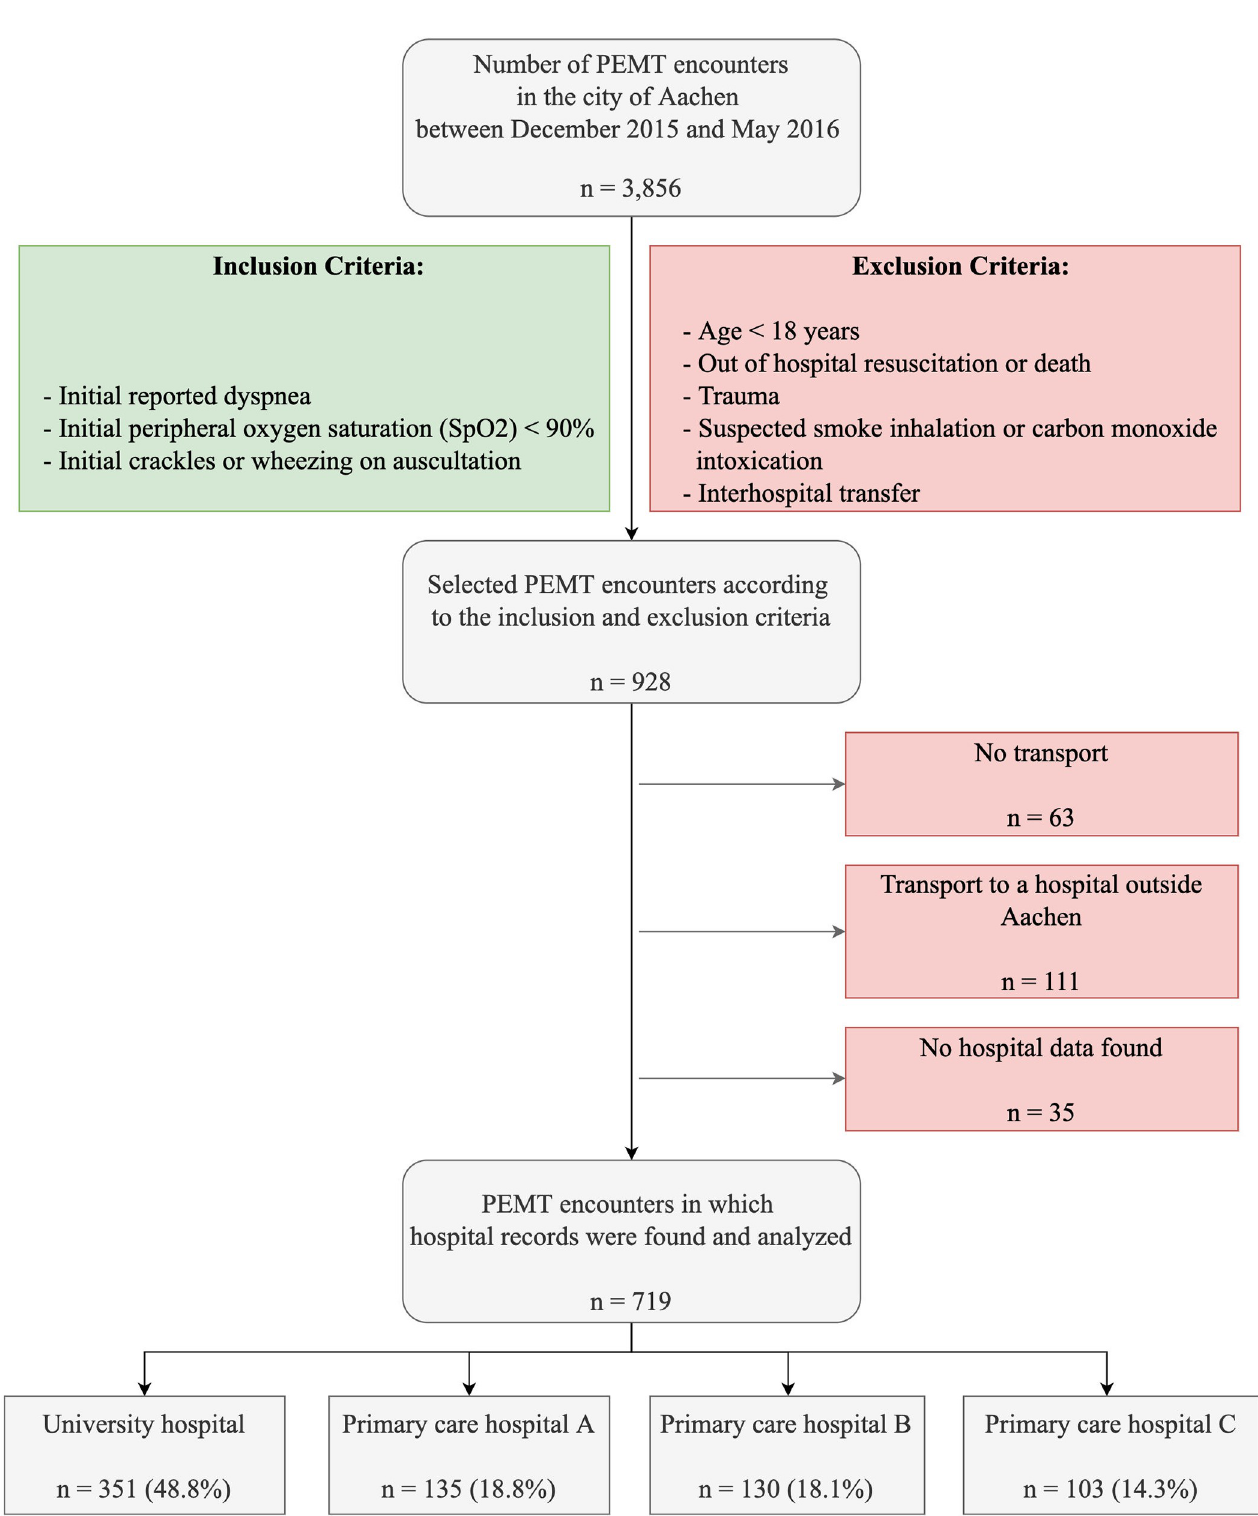
Fig 1. Study population considering the inclusion and exclusion criteria. PEMT physician-staffed emergency medical team.